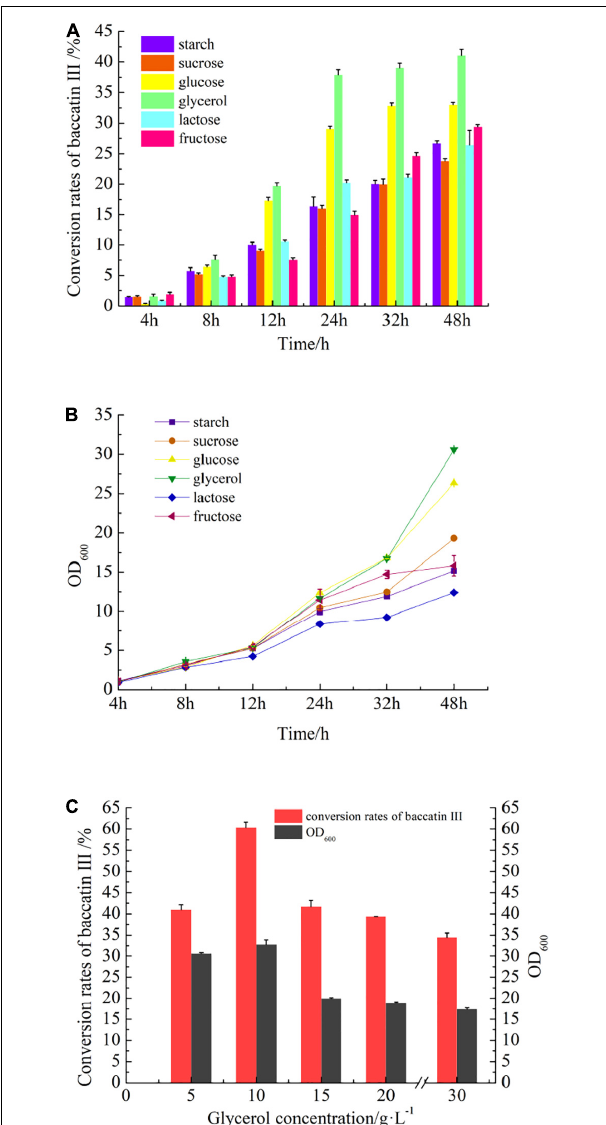
FIGURE 6 | The effect of carbon source optimization on baccatin III production and cell growth during fermentation. (A) The effect of different carbon sources on baccatin III production. (B) The effect of different carbon sources on cell growth. Take OD 600 value as the parameter of cell concentration. (C) The effect of glycerol content on baccatin III production and cell growth.